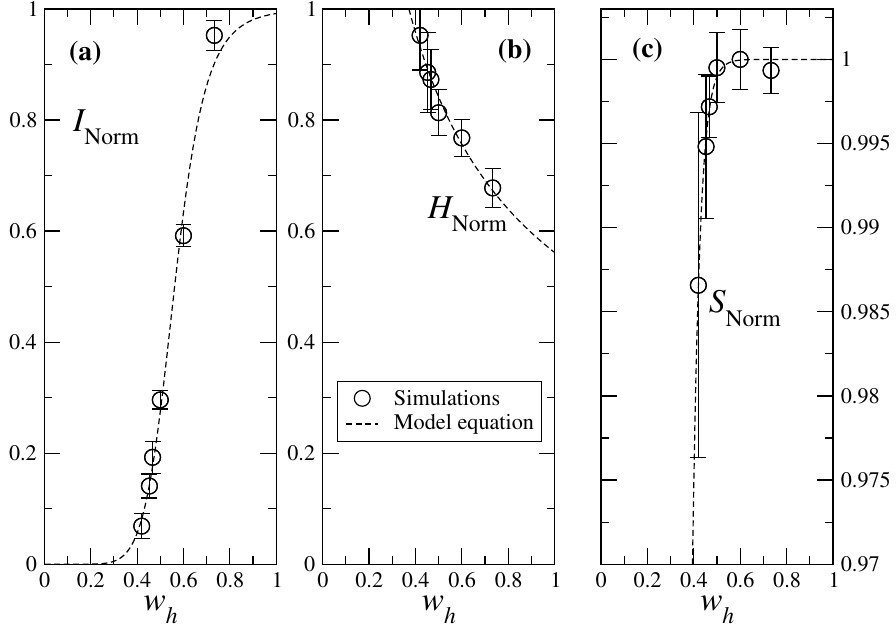
Figure 5. ( a ) Evaluation of the Malaria incidence in time series from model simulations at different settings of human-to-mosquito transmission efficiency (0.420 < w h < 0.733). The Hurst exponent is consistently close to 1.0 at the phase transition (when w h (close to a random walk stochastic state) with higher values of w h sion epidemic stage. For the same series ( b ) evaluation of the Hurst exponent and ( c ) evaluation of Shannon entropy. In each case we simulated the agent model 10